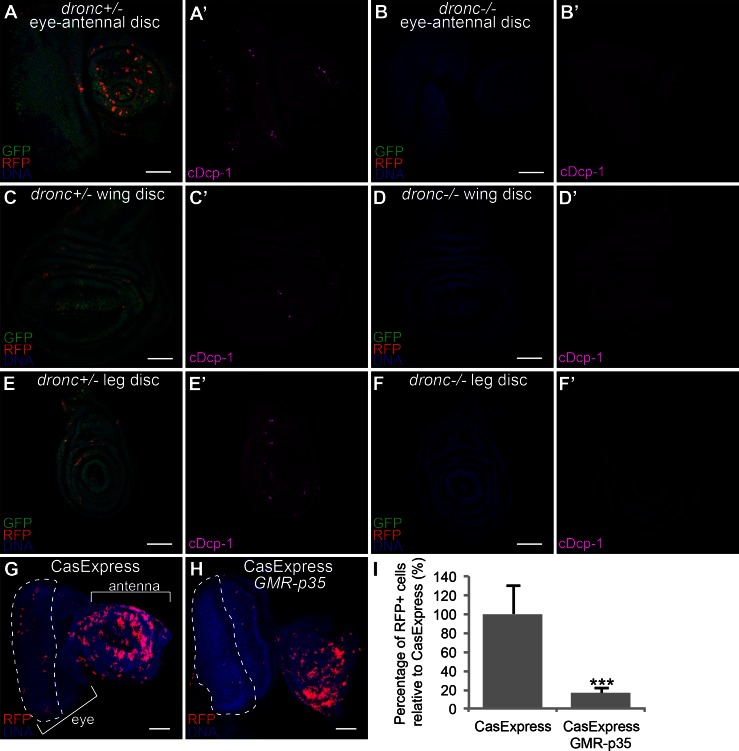
Caspase-dependence of CasExpress.(A–F) Confocal micrographs showing overlays of DAPI, RFP and GFP expression in third-instar larval eye-antennal disc (A–B), wing disc (C–D), and leg disc (E–F). CasExpress and G-trace were crossed into heterozygous (A, C, E) or dronc homozygous (B, D, F) dronc mutants. (A’–E’) Cleaved Dcp-1 staining of corresponding discs. Scale bars are 50 μm. (G–H) RFP expression in eye-antennal discs of late third-instar larvae with CasExpress and G-trace with (H) or without (G) GMR-p35. The dashed line encircles the region where p35 is expressed. (I) Quantification of of RFP: DAPI area. Error bars show standard error of the mean, and *** indicates p<0.001.